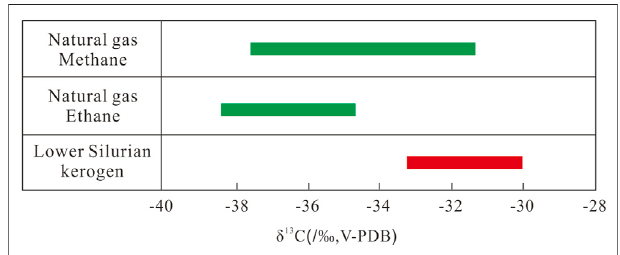
FIGURE 6 | Distribution of δ 13 C of Niutitang source rocks kerogen and natural gas in the study area.